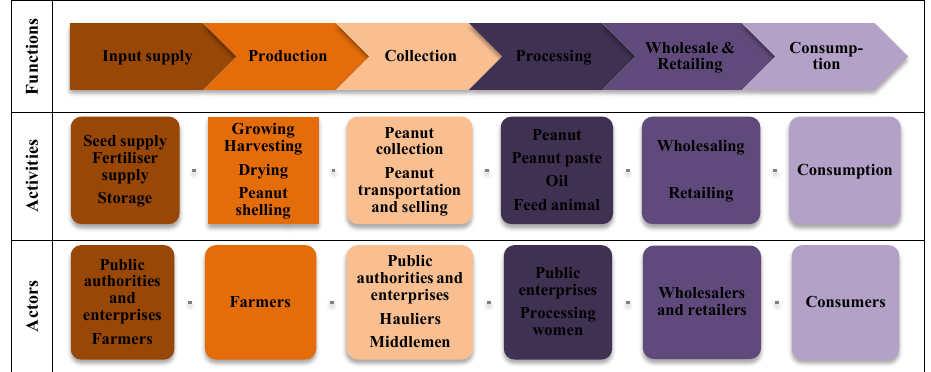
Figure 2. The peanut value chain mapping of